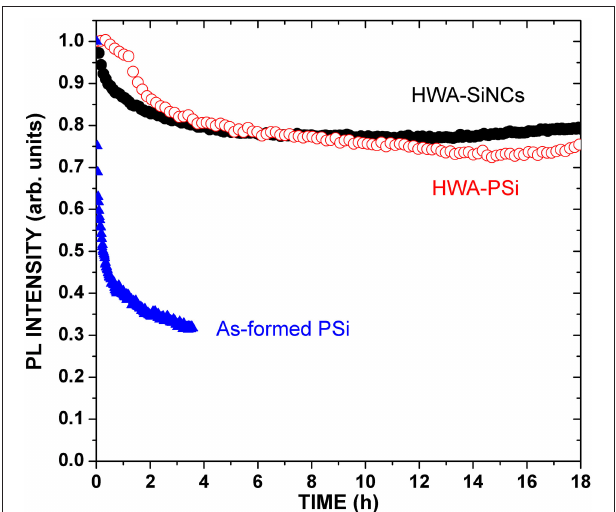
FIGURE 3 | PL peak intensity of HWA-treated SiNCs and PSi powders, as well as of an as-formed 80%-porosity PSi layer, as a function of time under continuous excitation at 405nm (1 mW on sample; spot diameter: 3mm).